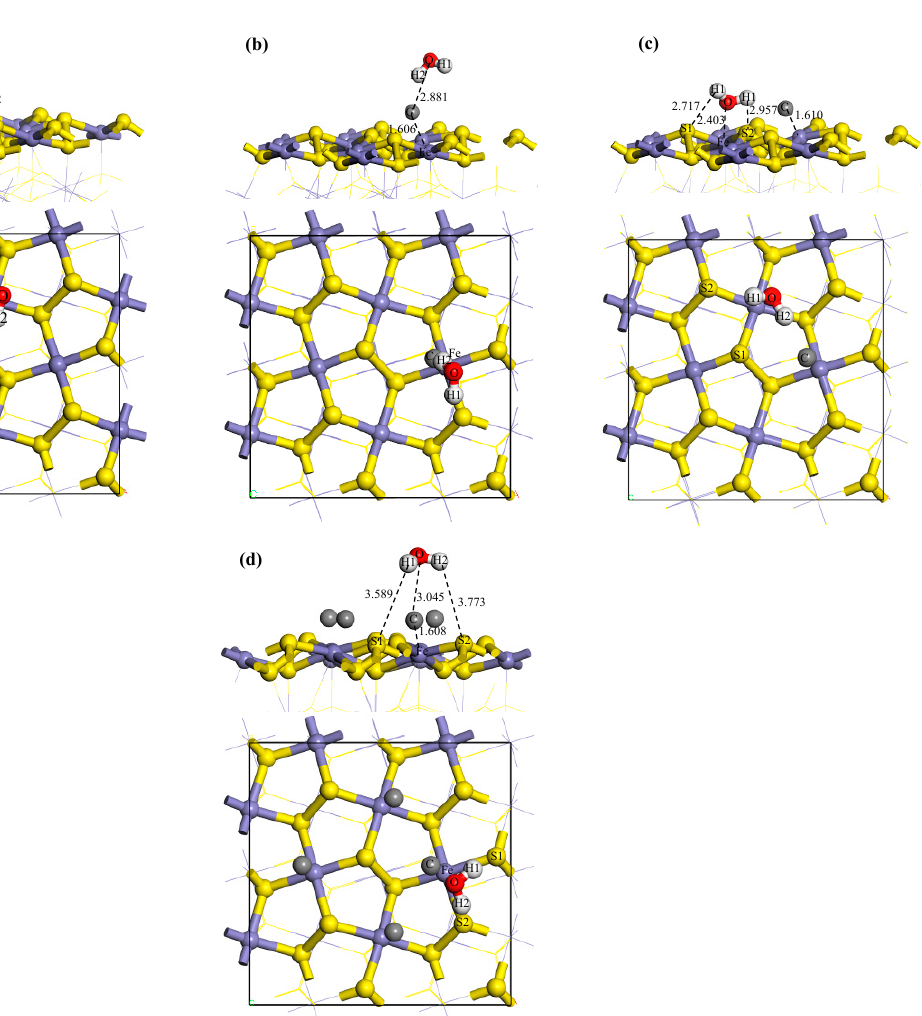
Figure 2. The adsorption configuration of H 2 O on the pyrite surface: ( a ) H 2 O / IS, the adsorption